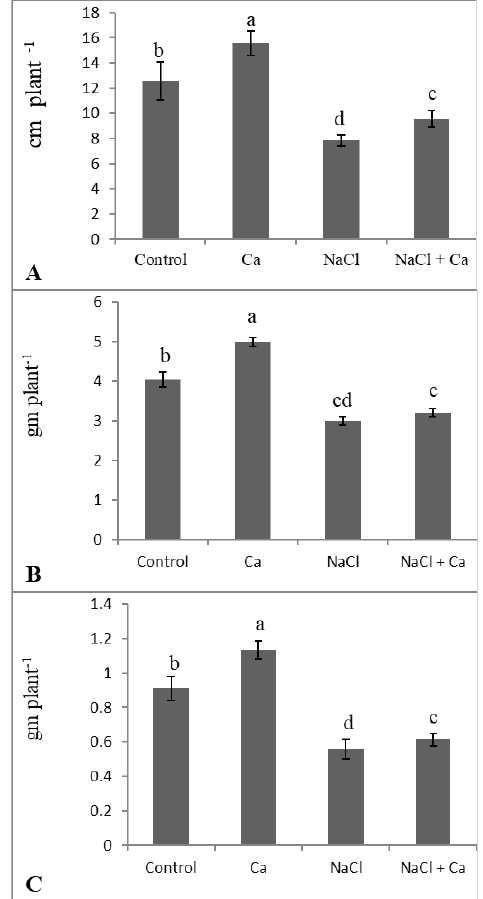
Fig. 1: Effect of salinity (100 mM NaCl) on (A) shoot length, (B) fresh and (C) dry weight of soybean ( Glycine max L.) with and without cal‑ cium supplementation. Data is mean (±SE) of three replicates and bars with different letters denote significant difference at P ≤